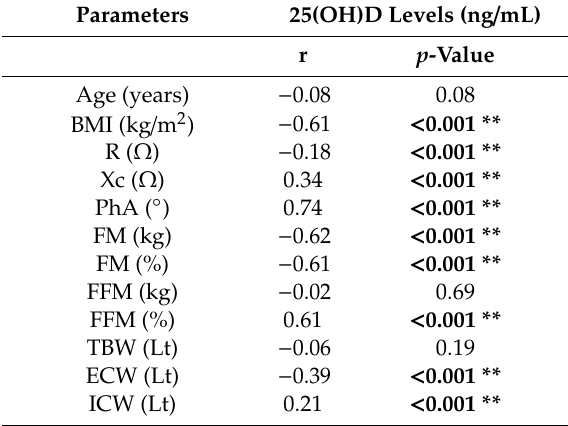
Correlations among 25(OH)D levels, age, anthropometric measurements, and body composition